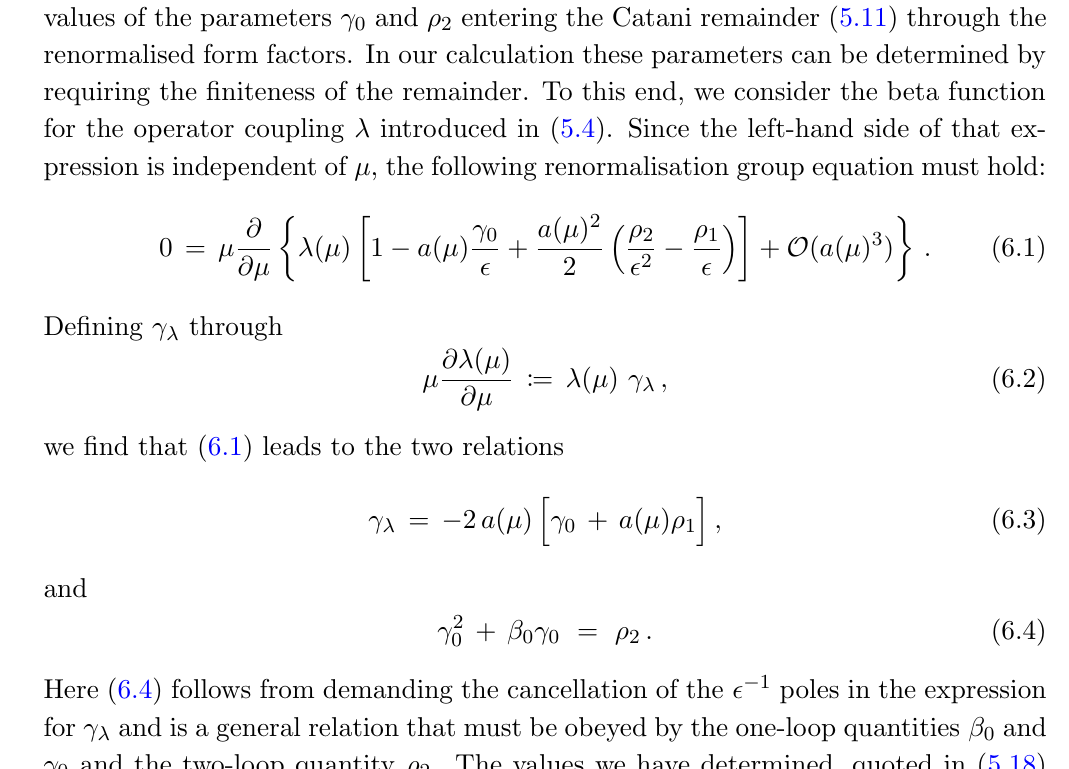
Figure 4 . Triple cut of the two-loop subminimal form factor F (2) independent of the theory and the operator chosen, because the three cut legs can only be